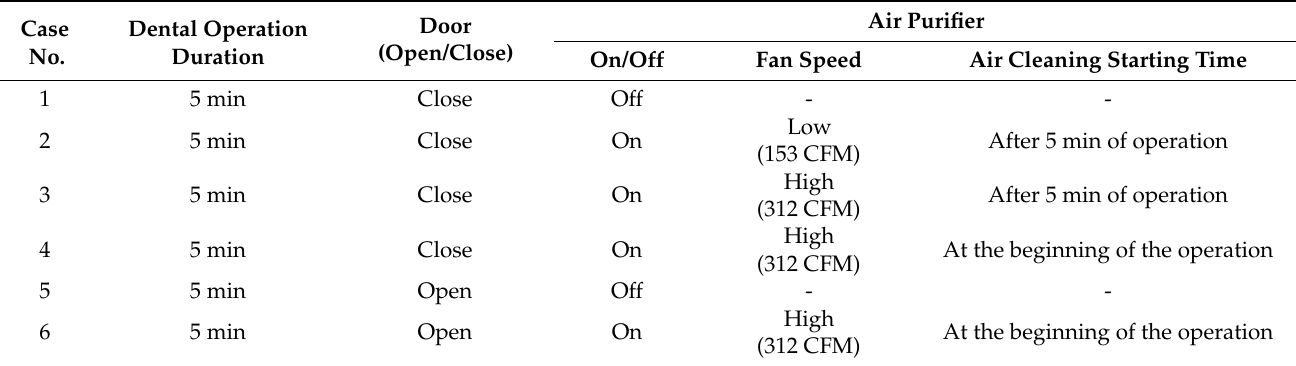
Table 1. Test cases and